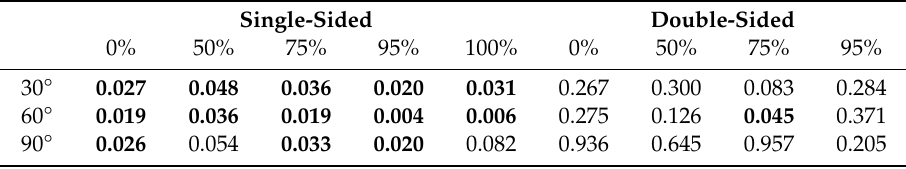
is 180 µm, the contact angle, θ , is taken as 0°, as the cellulose paper is a fully wetting material, and the per unit area. r is e ff ective pore radius ( r = D c / 2). viscosity of water, µ , is 1 × 10 −3 N ‧ s/m 2 . The evaporation rate, 𝑞 0 , is the volumetric evaporation rate per unit area. r is effective pore radius ( r = D c /2). Table A1. p -values for the data presented in Figure 7 (single- and double-sided etched channels without tape), generated using a two-tailed, unequal variance t-test comparing the 30 ◦ , 60 ◦ , and 90 ◦ conditions to the 0 ◦ (vertical wicking). Values below 0.05 are in bold text. Nearly all of the values in the no tape, single-sided condition have a p -value below 0.05 due to that condition’s vertical wicking results having considerable variability.